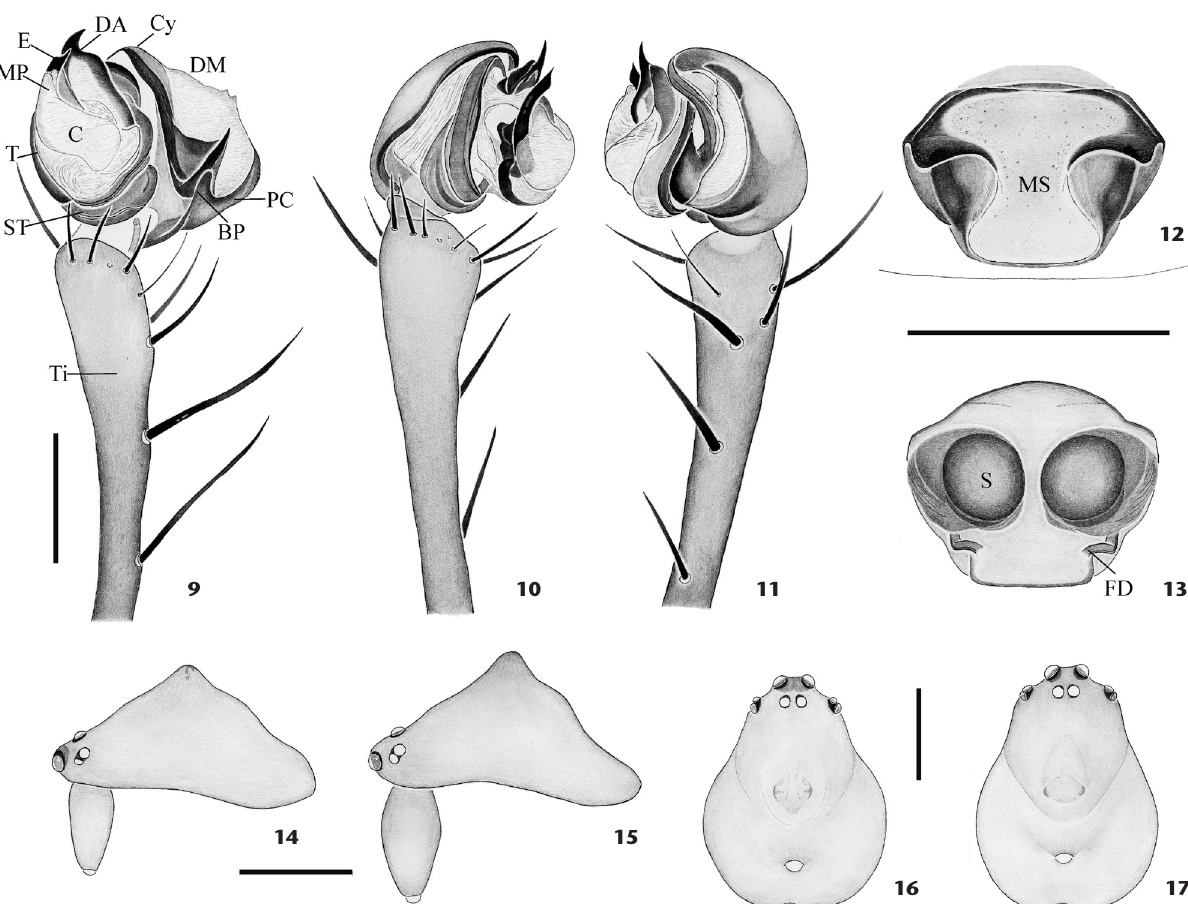
Figs. 25-29, 59-64 Diagnosis. The male of Gelanor juriti resembles that of G. al- tithorax by median process of conductor narrow near embolus, but differs in the distal apophysis of conductor slightly sclerotized and rounded at apex (Fig. 25, 59, 60, 62, 63), by distal margin of cym- bium concave (Fig. 25) near of the basal process of paracymbium. The females of Gelanor juriti resembles that of G. altithorax by me- dian septum of epigynum medialy narrow, widened anteriorly and posteriorly (Figs. 28, 64), but differs by lower posterior enlargement, oval spermathecae close together and fertilization ducts forming loops (Fig. 29). Males and females of Gelanor juriti distinguished from G. altithorax by carapace not acuminate in the median